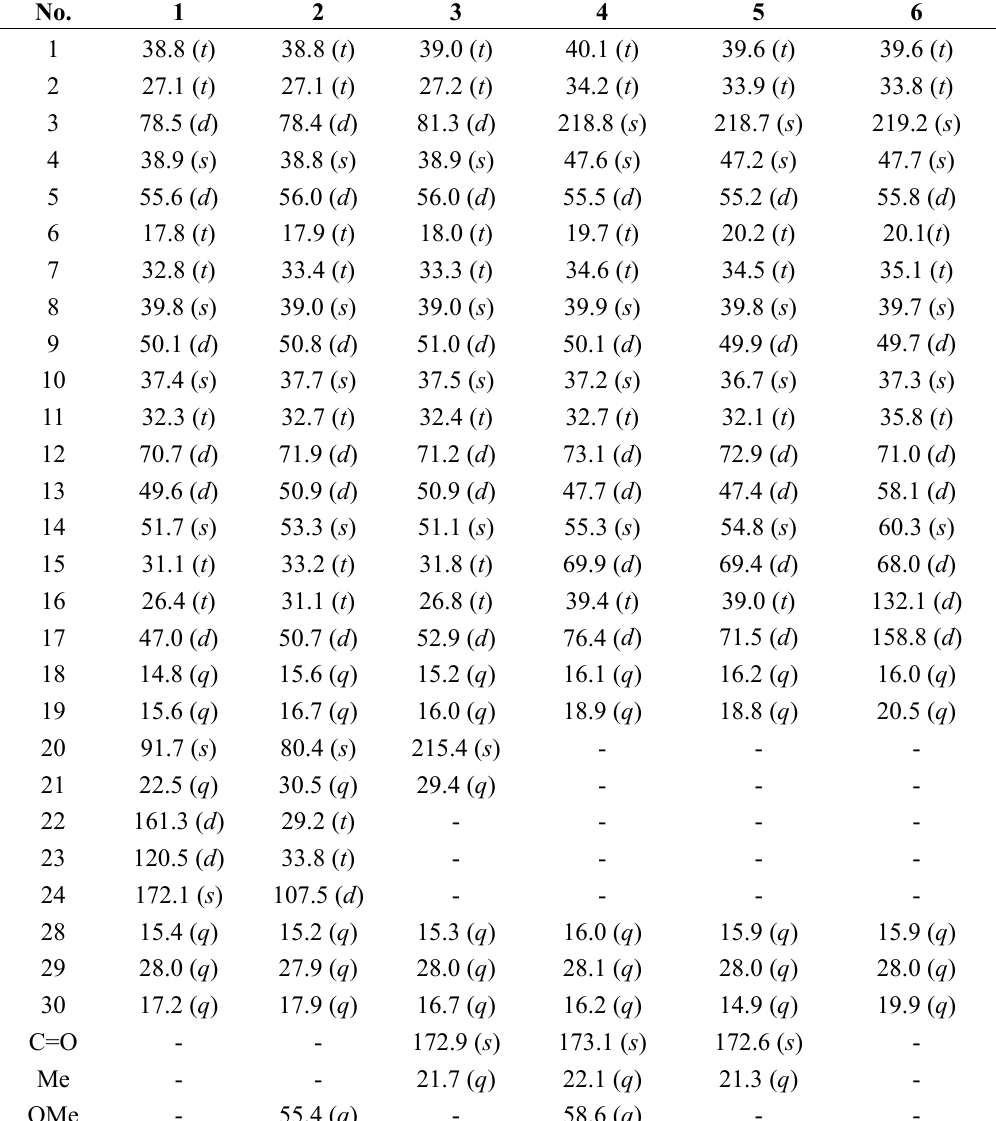
Table 2. 13 C-NMR data of compounds 1 – 6 in CDCl